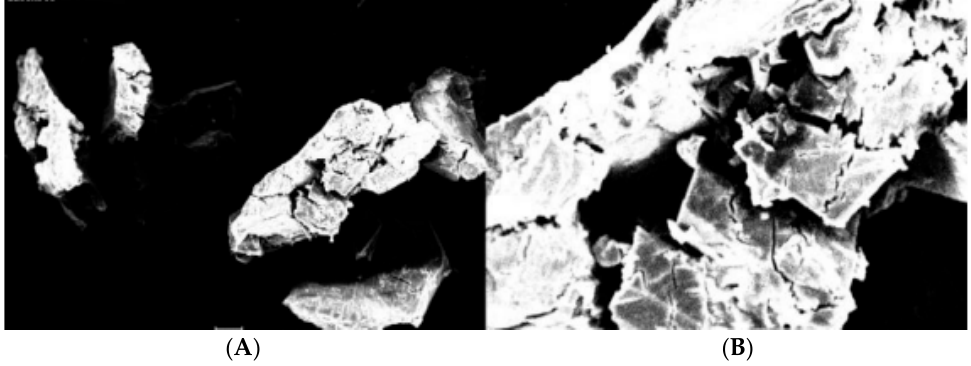
Figure 7. SEM images of ketoconazole inclusion complexes (×100, A ), (×500, B ).